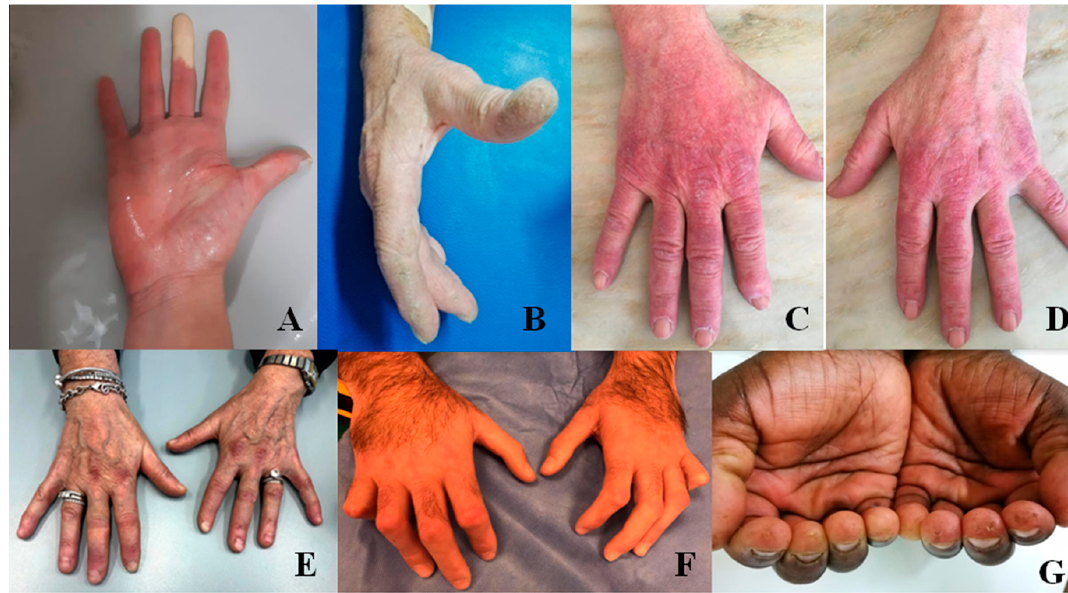
Figure 1. The hands in patients with Interstitial Lung Disease (ILD) secondary to rheumatic conditions. ( A ): Raynaud’s phenomenon in ischemic phase during a provocation test; ( B ): mechanic’s hands; ( C , D ): Gottron’s signs; ( E ): Gottron papules; ( F ): sclerodactyly with clawed shape in systemic sclerosis; ( G ): pitting scars in a patient with systemic sclerosis.